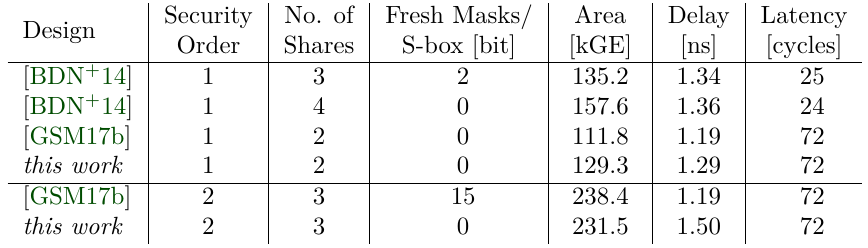
Table 1: Performance figures of round-based Keccak [1088,512] permutation. (using Synopsis Design Compiler, and UMC 130 standard cell library, excluding PRNGs)